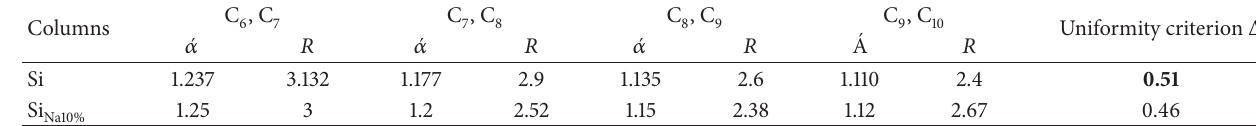
Table 5: Separation efficiency parameters of selected stationary phases using aromatics as probes. Benzene, toluene Toluene, ethyl benzene Ethyl benzene, propylbenzene Propylbenzene, butylbenzene Column